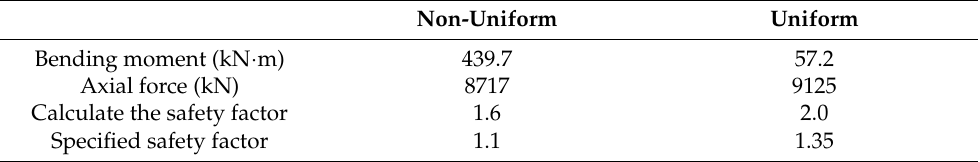
Figure 24. Simulated internal force of S1ZK0 + 735 m section. ( a ) Non ‐ uniform axial force diagram; ( b ) Non ‐ uniform bending moment diagram; ( c ) Uniform axial force diagram; ( d ) Uniform bending moment diagram. Table 6. S1ZK0 + 735 m section lining safety factor calculation value, according to Method